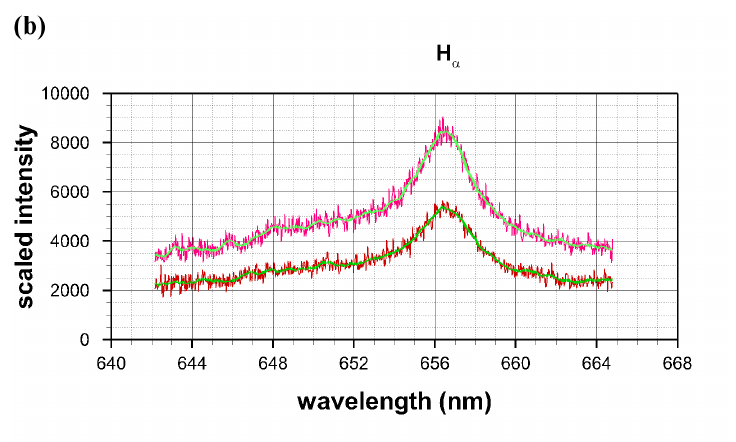
Figure 10. Comparison of spectra with and without mirror: ( a ) for 300 ns time delay; and ( b ) for 800 ns time delay. Slit height: 6.15 mm. Reproduced from Ref. [31] with permission.